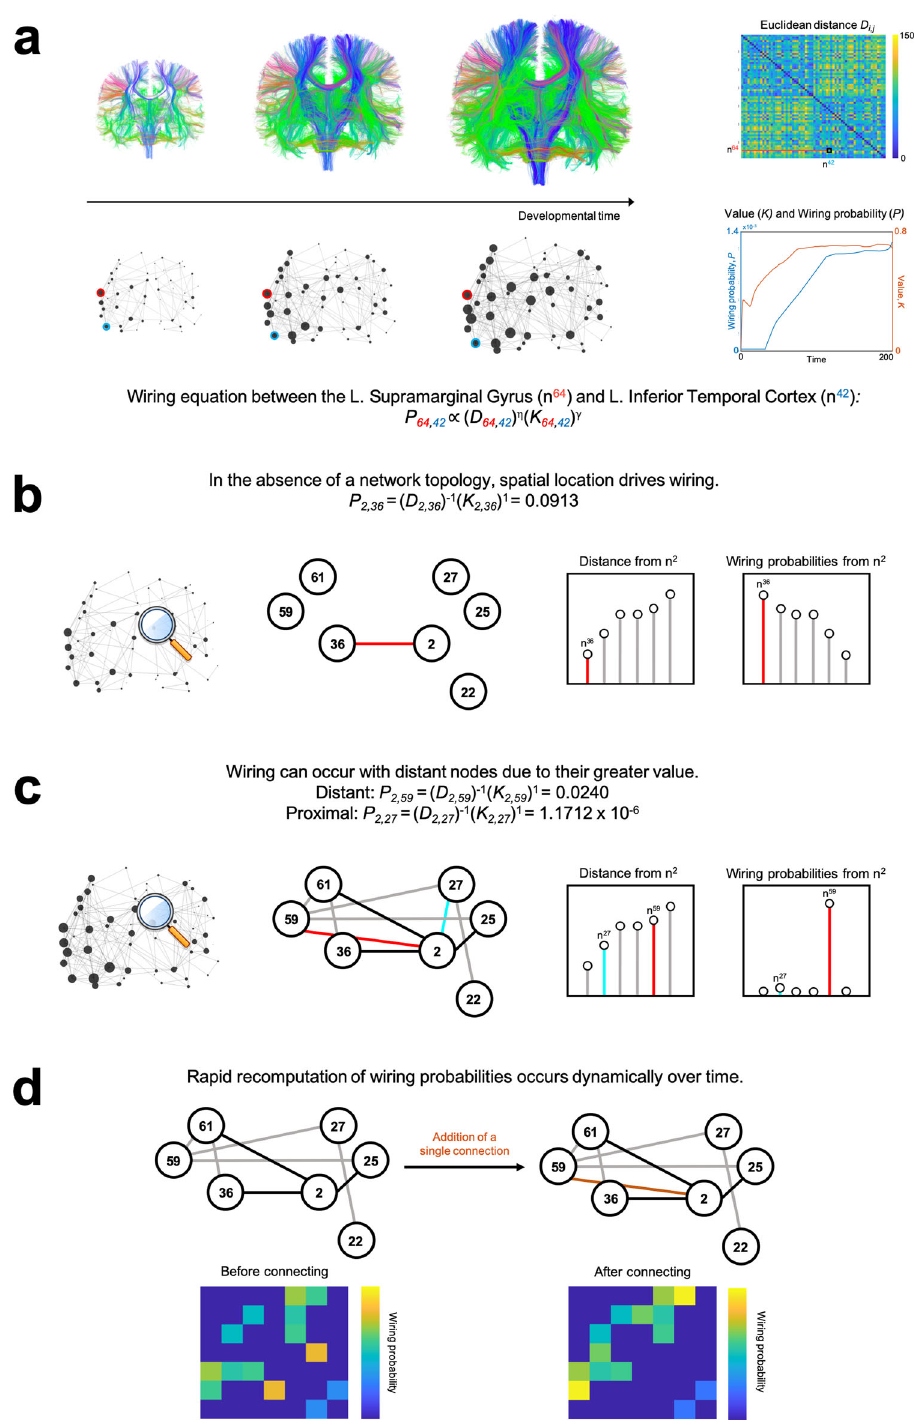
Fig. 1 Updating wiring probabilities within the generative network model iteratively, based on dynamically changing graphical structures. a The brain ’ s structural connectivity is modeled as a generative network which grows over time according to parametrized connection costs, ( D i,j ) η and values, ( K i,j ) γ . In this illustration, we use subject one ’ s optimal model. b Early in network development, the absence of a topology leads to proximal nodes being much more likely to form connections. The displayed distances and probabilities are from the right caudal anterior cingulate ( n 2 ), which corresponds to row ( D 2 ,:) η and ( P 2 ,:). We display it ’ s six nearest cortical regions. c Later, the relative values ( K i,j ) between nodes in fl uence connection probabilities, such that nodes which are more distant (e.g., left rostral anterior cingulate, n 59 in red) may be preferred to nodes which are closer (e.g., right superior frontal cortex, n 27 in cyan). d As costs and values are decoupled, the wiring probability can be rapidly recomputed when dynamic changes in graphical structure occur over developmental